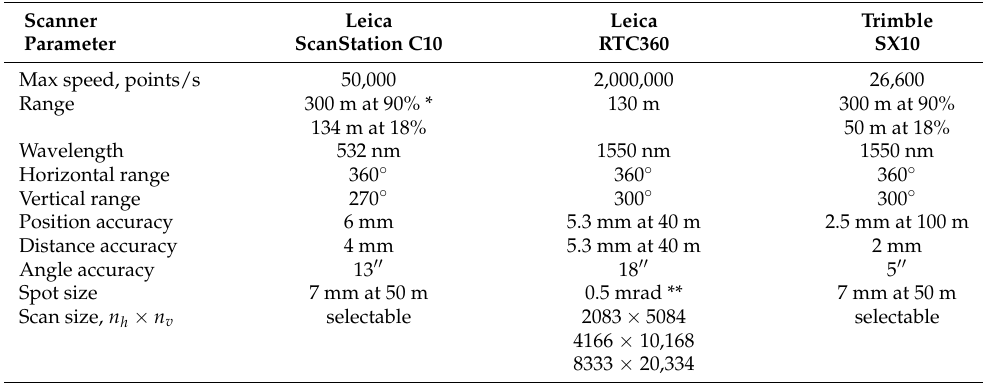
Table 2. Specifications of the scanners